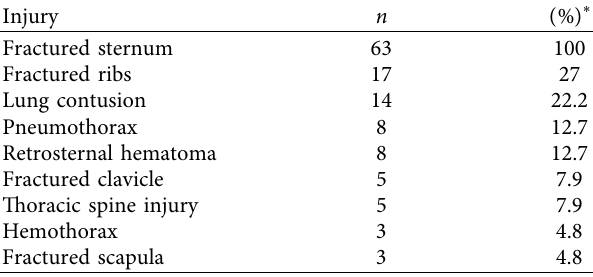
Table 5: Chest injuries in patients with sternal